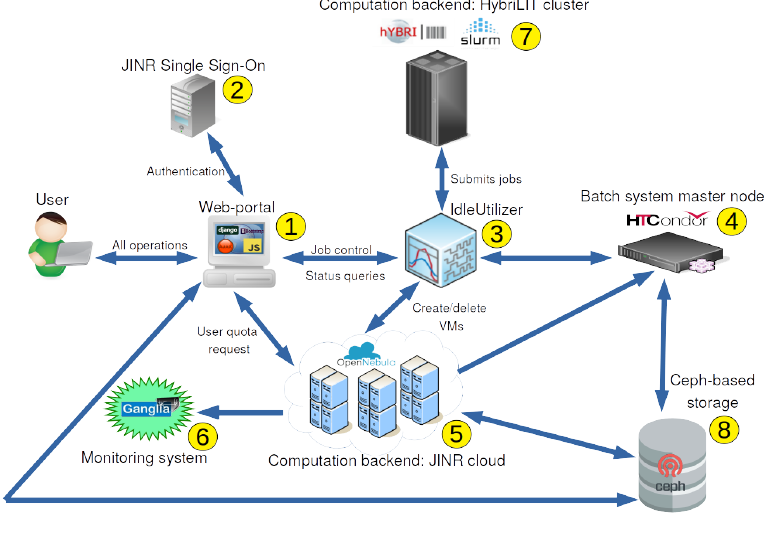
Figure 1. Basic schema of the workflow and main components of the JINR SaaS